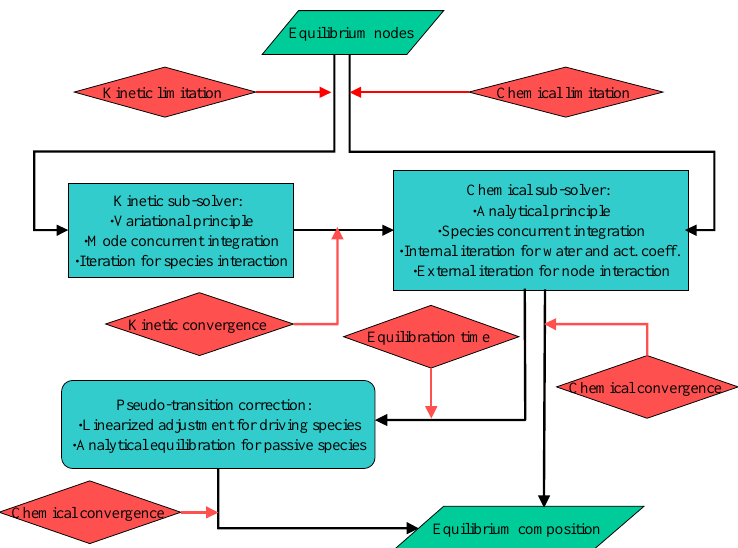
Figure 4. Formalism of the equilibrium